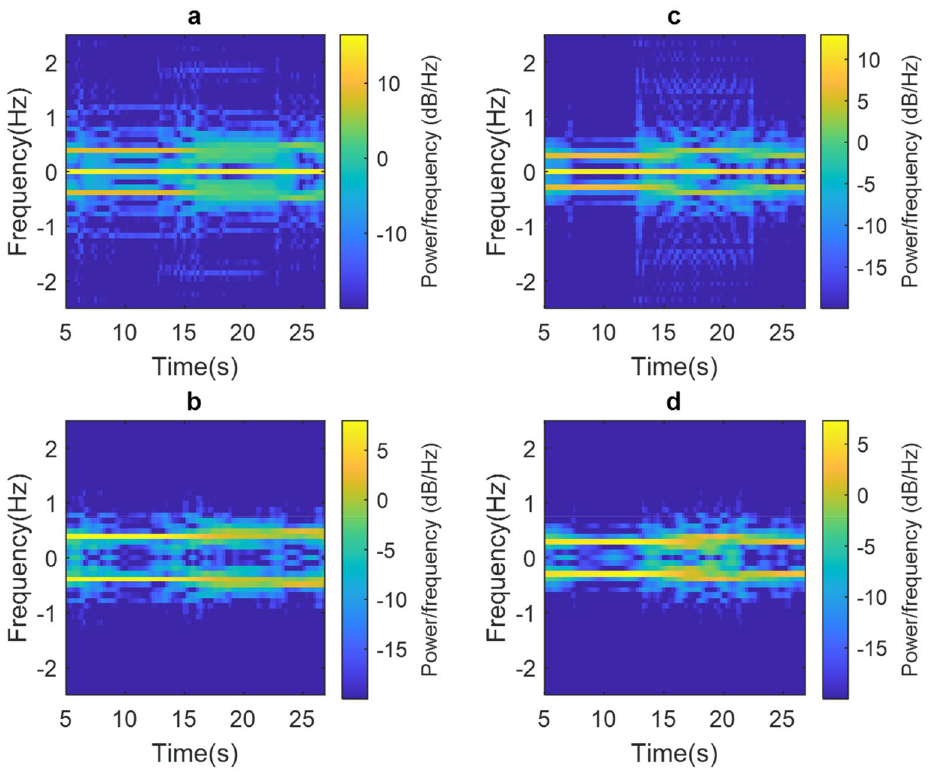
Figure 6. ( a ) Non-corrected spectrogram and ( b ) corrected spectrogram for the first arm movement and ( c ) uncorrected spectrogram and ( d ) correction spectrogram for the second arm